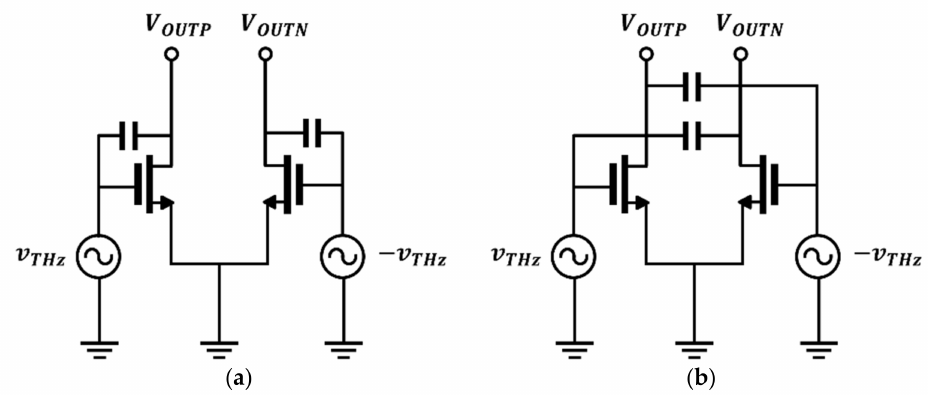
Figure 1. CMOS detector configuration: ( a ) Previous detector circuit with gate-drain capacitors; ( b ) proposed concurrent-mode detector.